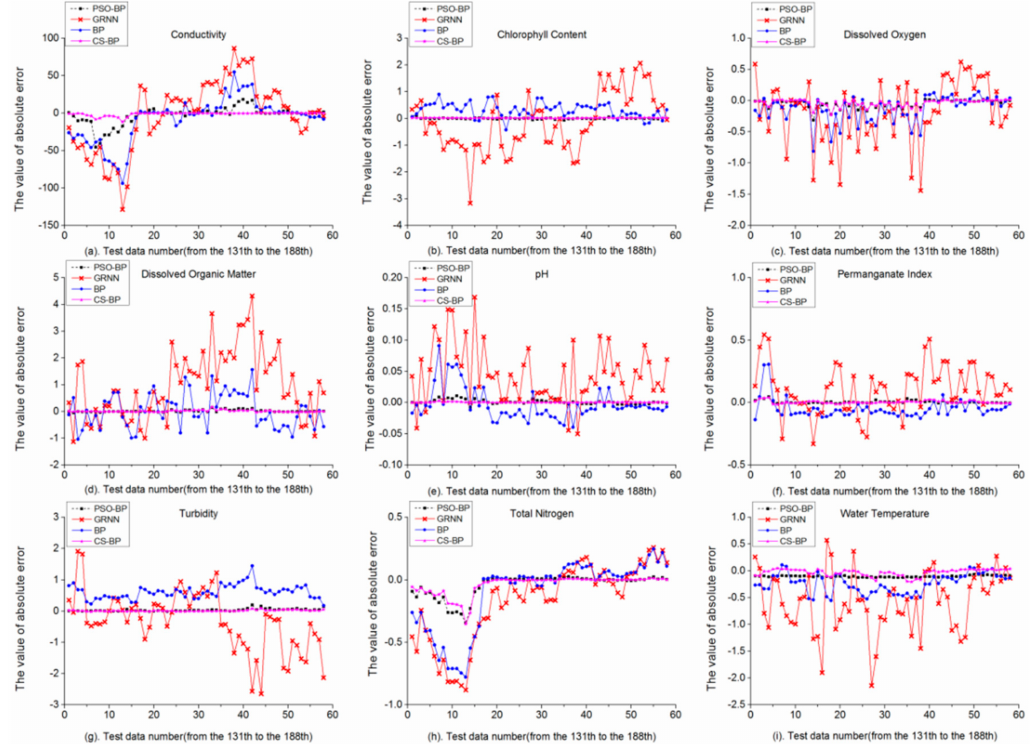
Figure 7. The absolute errors of water quality indicators of four models of part A in Scenario 3.